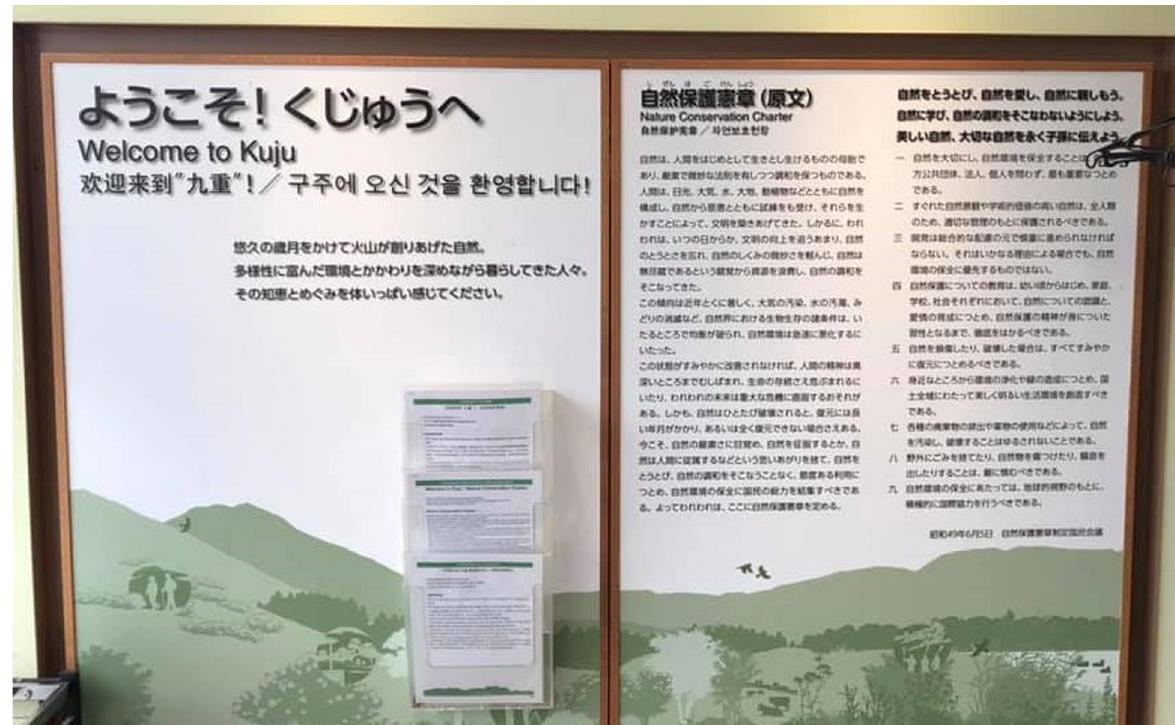
Fig. S1. Signs in Japanese with English headings and grab-sheets (left-centre). Source: photo taken by